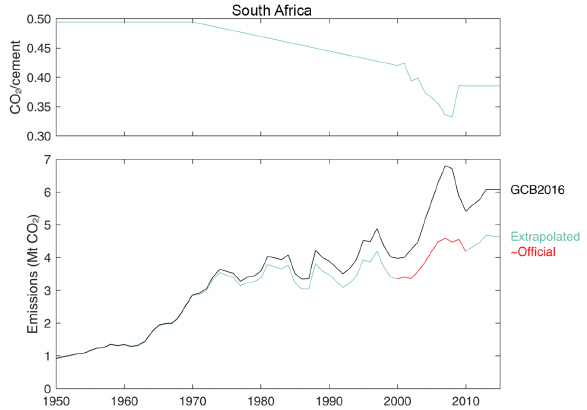
Figure C32. Saudi Arabian cement and clinker production, 1990– 2017 (Yamama Cement, 2018; USGS, 2018; van Oss, 1994–2018).